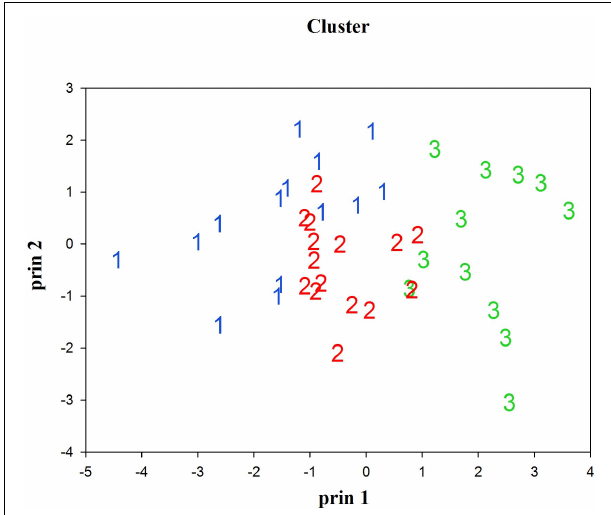
FIGURE 3 | Plot of cluster grouping by principal 1 (PC 1) and principal 2 (PC